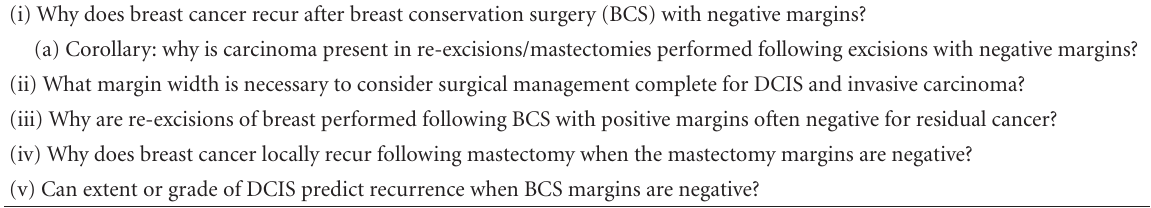
Table 1: Surgical margins: persistent management